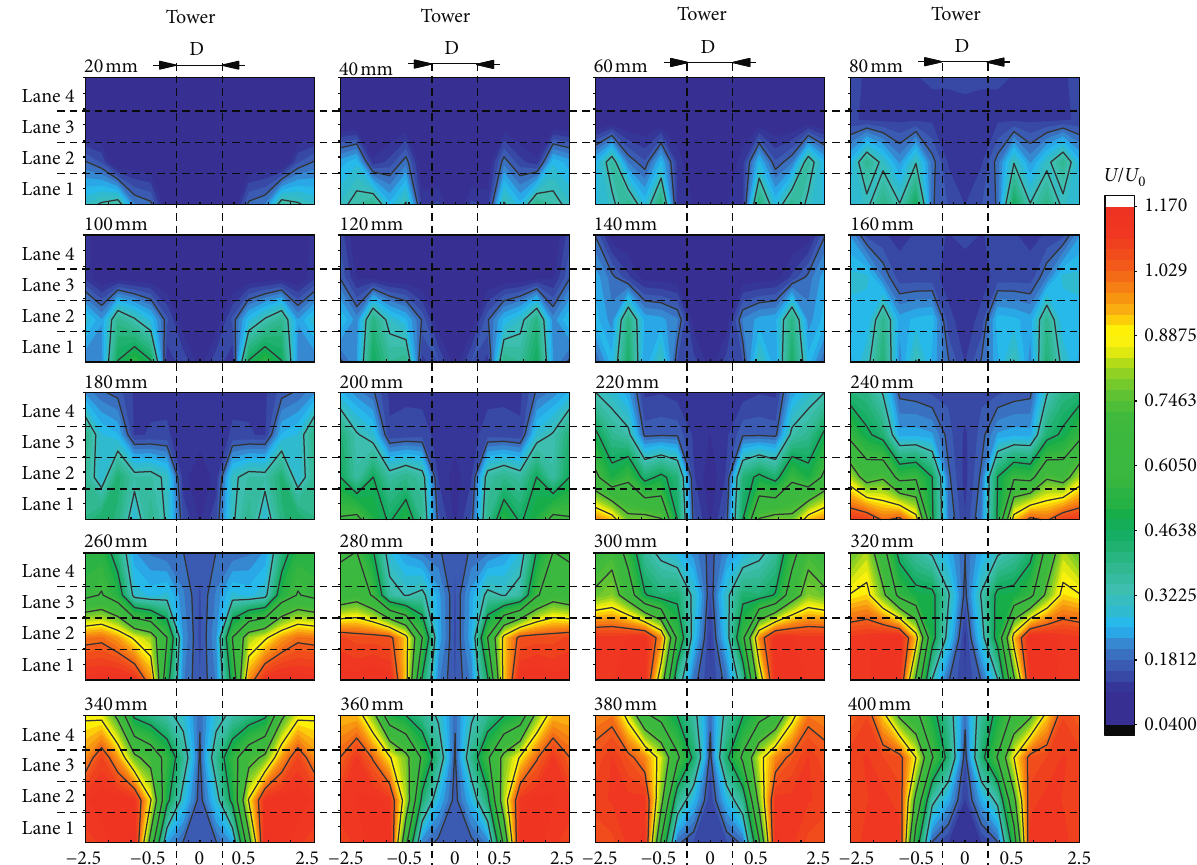
Figure 10: Contours of wind field above the bridge deck in the presence of WB-3